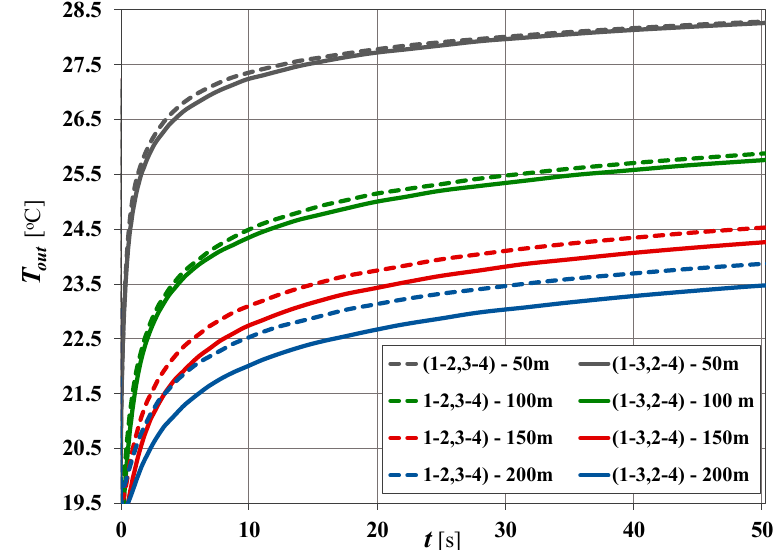
Figure 10. Time evolutions of the outlet fluid temperature for various borehole lengths.